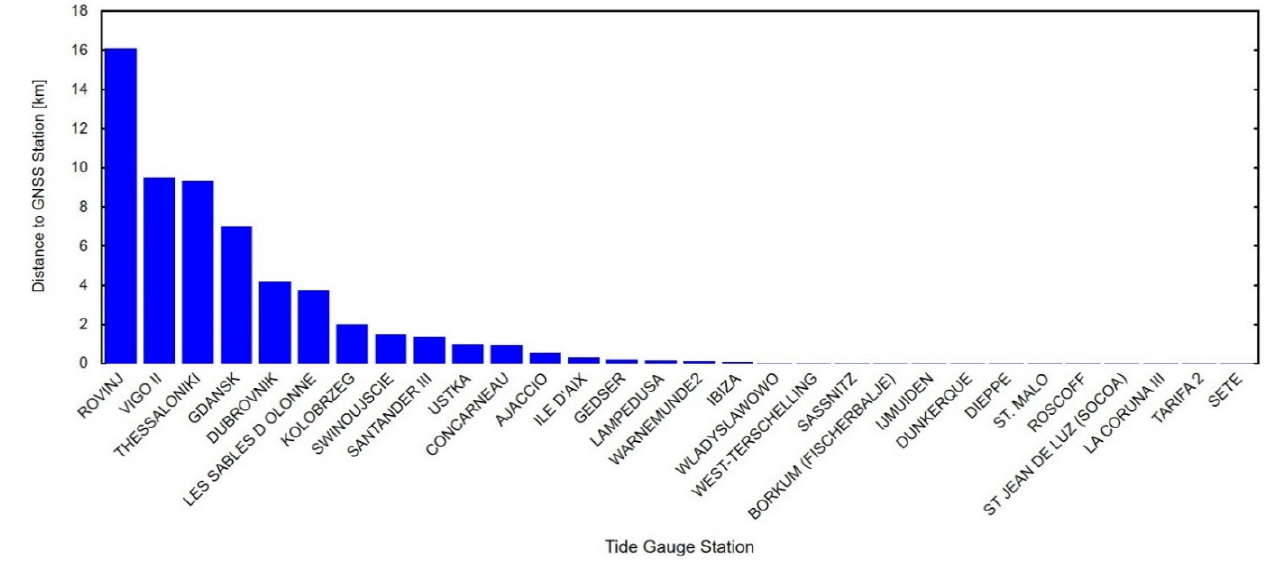
Figure 6. Distance between GNSS stations and the nearest TG (the longest distance between a TG station and a GNSS station was 16.069 km, and the shortest distance between a TG station and a GNSS station was 0.002 km).